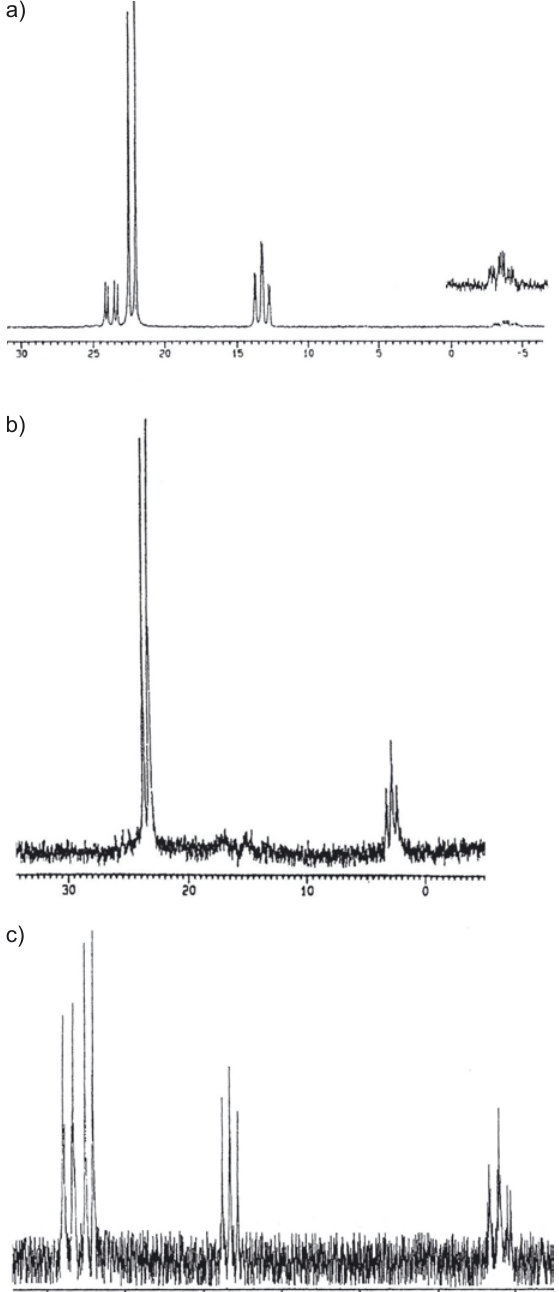
Figure 3. The 31 P NMR spectra of the products obtained using (a) the diethylether / Na CO -water interface process (b) the solid phase 2 3 process on Al O / KOH (c) toluene in the presence of NEt 2 3